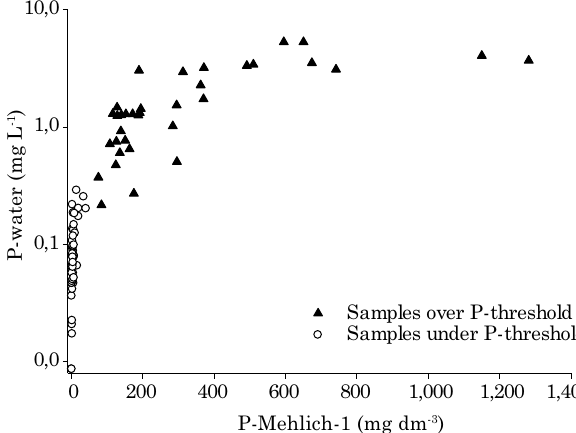
Figure 6. Phosphorus-water and P-Mehlich-1 values in 82 soil samples from the State of Santa Catarina, Brazil. The samples were previously classified using the model P-threshold = 40 + Clay as below (white circles) or above (black triangles) the P-threshold.